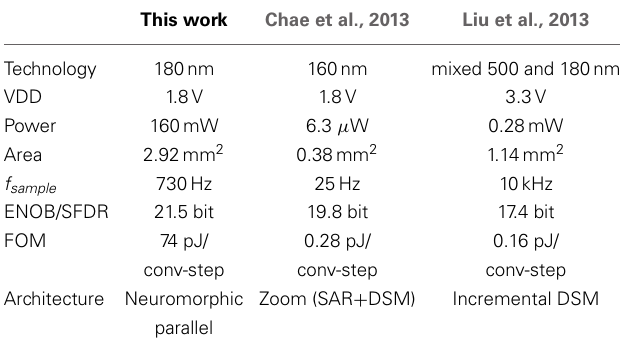
Table 9 | Low sample rate, high resolution